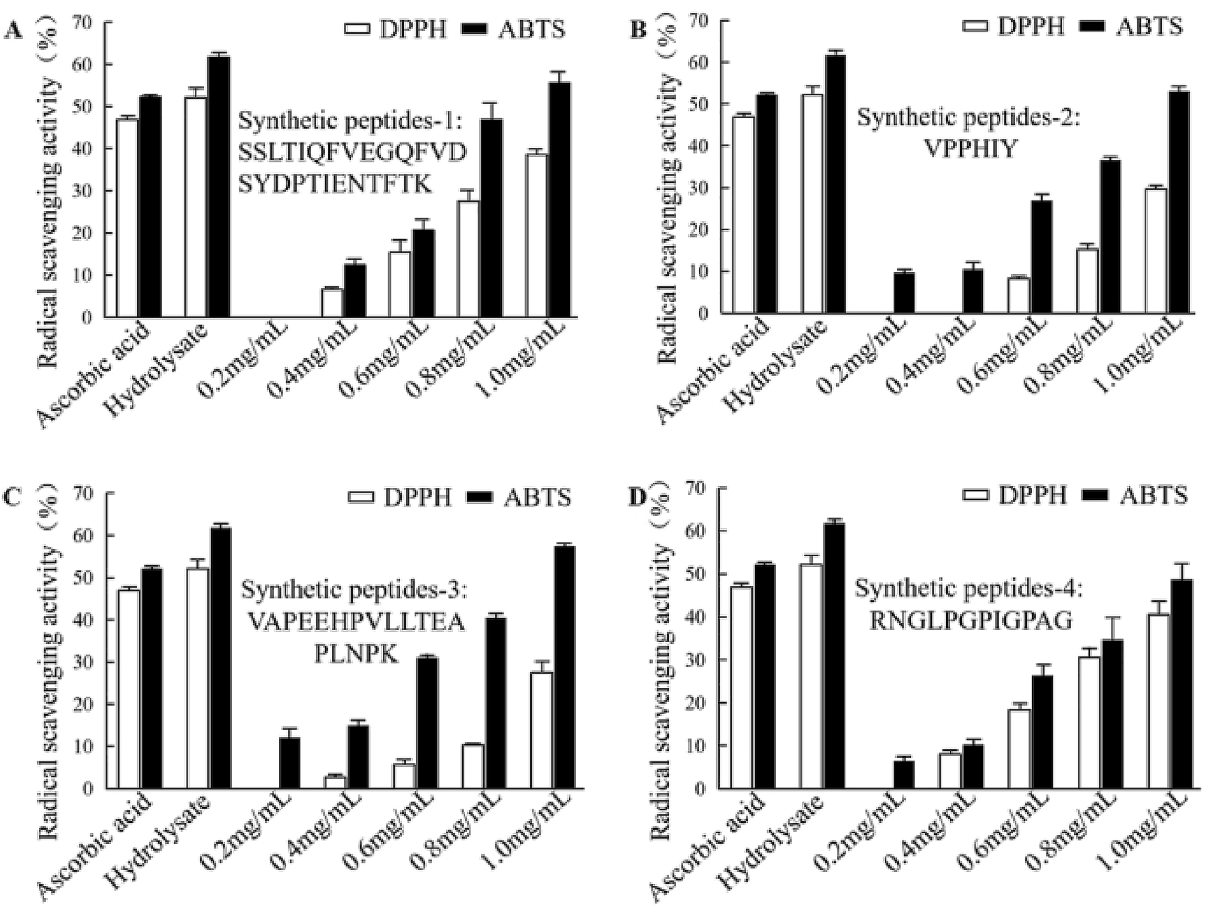
Figure 5. Antioxidant activities of the identified peptides using synthetic peptides. ( A ) SSLTIQFVEGQFVDSYDPTIENTFTK; ( B ) VPPHIY; ( C ) VAPEEHPVLLTEAPLNPK; and ( D ) RNGLPGPIGPAG. Ascorbic acid at 0.5 mg/mL and the hydrolysates at 1.0 mg/mL were used as